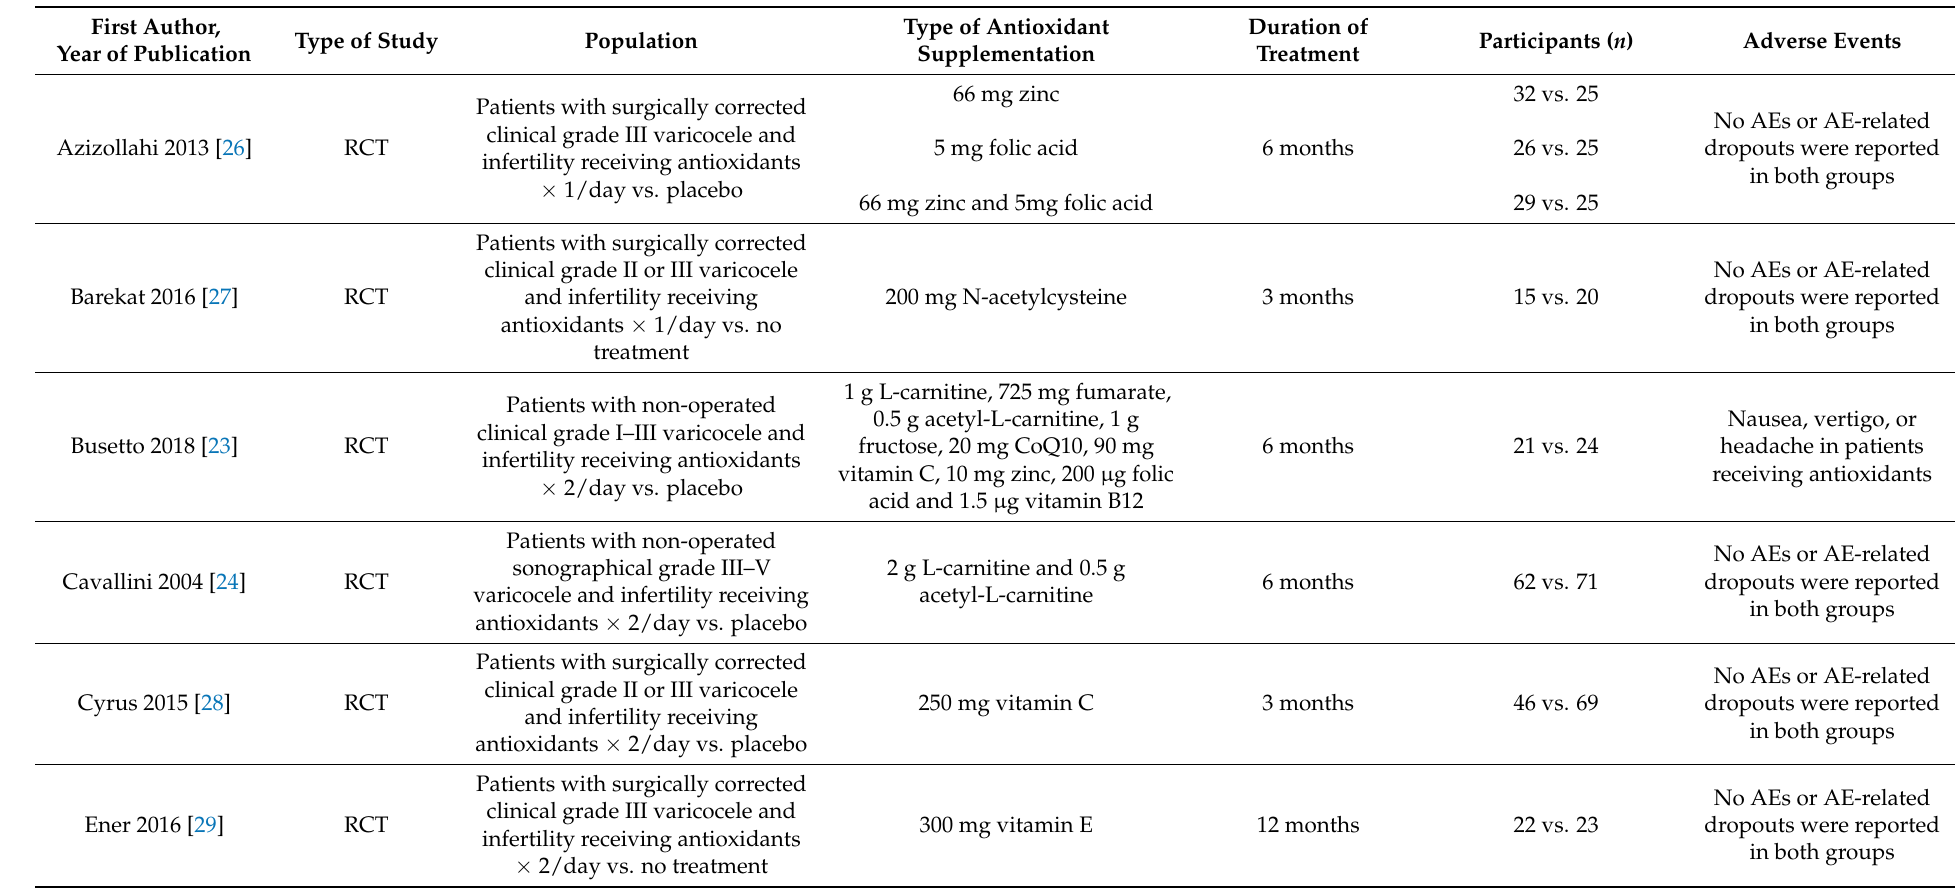
Table 1. Baseline characteristics of the included